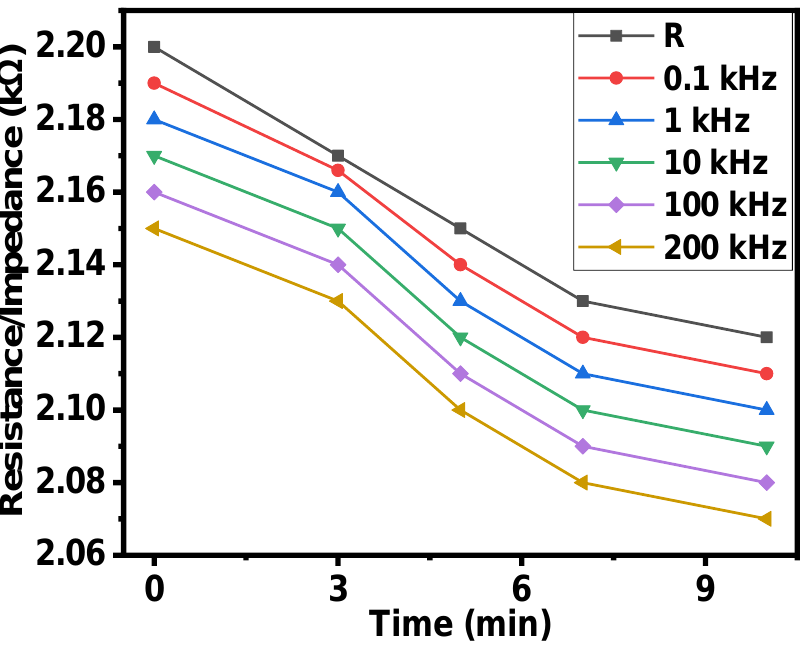
Figure 7. Effect of vibration on the resistance/impedance of the surface-type shockproof resistor with respect to time.